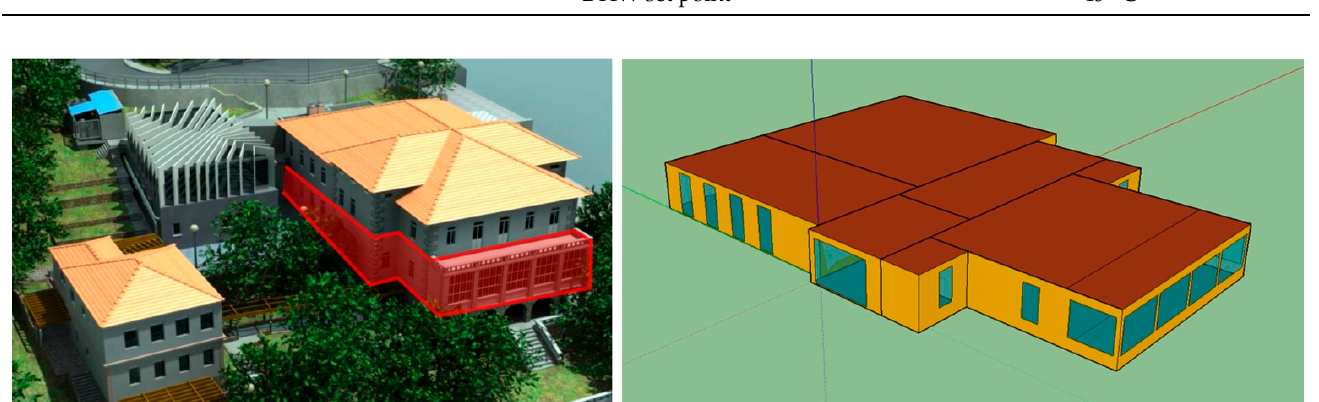
Figure 1. The building with the restaurant area considered in the case study is marked in red ( left ) and a 3D thermal model of the restaurant area ( right ).